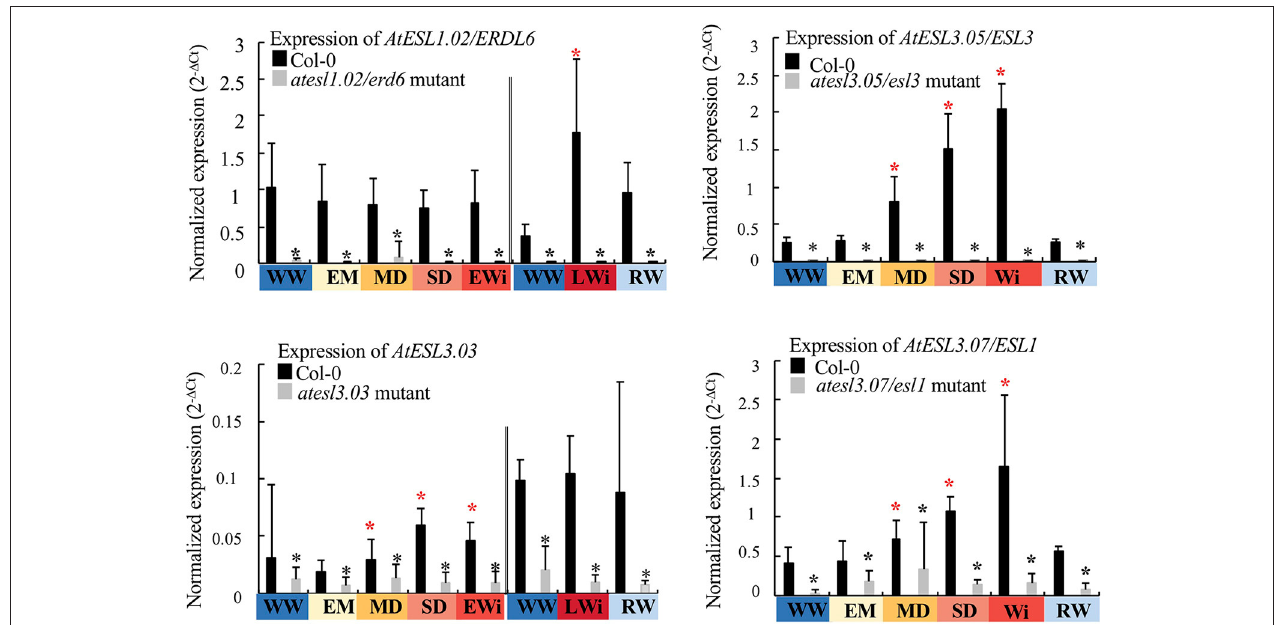
FIGURE 8 | Expression level of AtESL1.02/ERDL6 , AtESL3.03 , AtESL3.05/ESL3 , and AtESL3.07/ESL1 in the leaves of T-DNA insertional mutants: atesl1.02/erdl6 , atesl3.03 , atesl3.05/esl3 , and atesl3.07/esl1 . Comparison of the expression levels of the corresponding gene in its respective mutant under WW, WD, and after RW conditions as a function of the four phases of water deficit: EM, early mild water deficit; MD, moderate water deficit; SD, severe water deficit; EWi, early wilting; LWi, late wilting; Wi, wilting phase; Wi, wilting phase, the average of the values of EWi and LWi when these values are not different. The 2 − 1 Ct values are normalized according to AtPP2a expression. On the left of the double bar, the level of gene expression does not show any significant variation during the growth kinetics under WW conditions: the gene expression in EM, MD, SD, and EWI phases is compared to the mean value measured under the WW condition during these periods. On the right of the double bar, the gene expression being significantly different at the end of the growth kinetics (49–50 dps): the gene expression in LWi and RW is compared to that observed under WW conditions in those late developmental phases. Each value represents the mean of three biological repeats ( ± SD). Black asterisks correspond to significant differences between atesl mutant and Col-0 plants, determined by the Mann–Whitney test ( p < 0.05). Red asterisks correspond to significant differences determined by the Kruskal–Wallis test, followed by a Dunn’s test for multiple comparisons with Bonferroni correction ( p < 0.05).